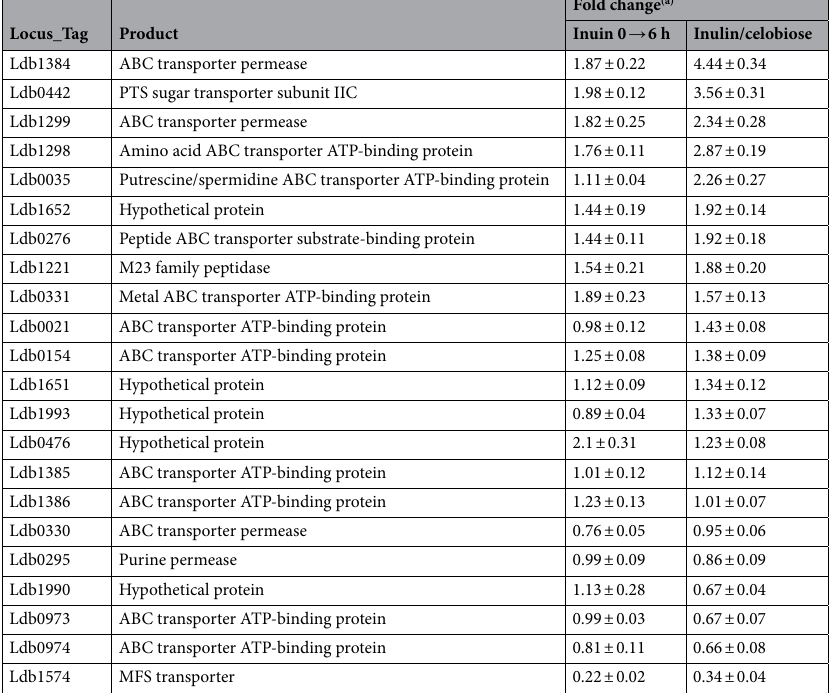
Table 1. Transcription levels of 22 candidate genes on inulin compared to cellobiose by RT-PCR. (a) Inulin 0 → 6 h; the range of the gene expression levels on inulin from 0 to 6 h, Inulin/Cellobiose; the range of the gene expression level on inulin compared to